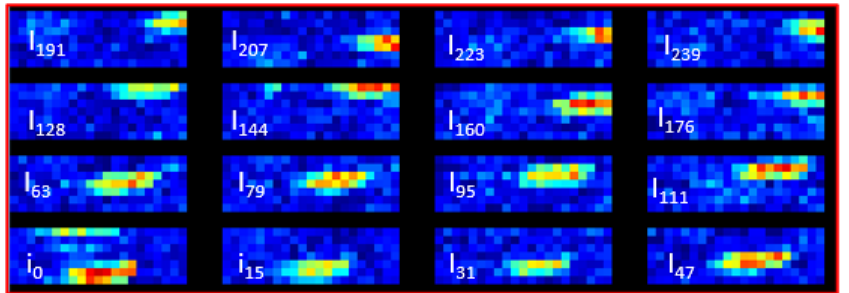
Figure 8. Sequence of the sub-areas of target T0 extracted with a frequency of one every sixteen instants of time.